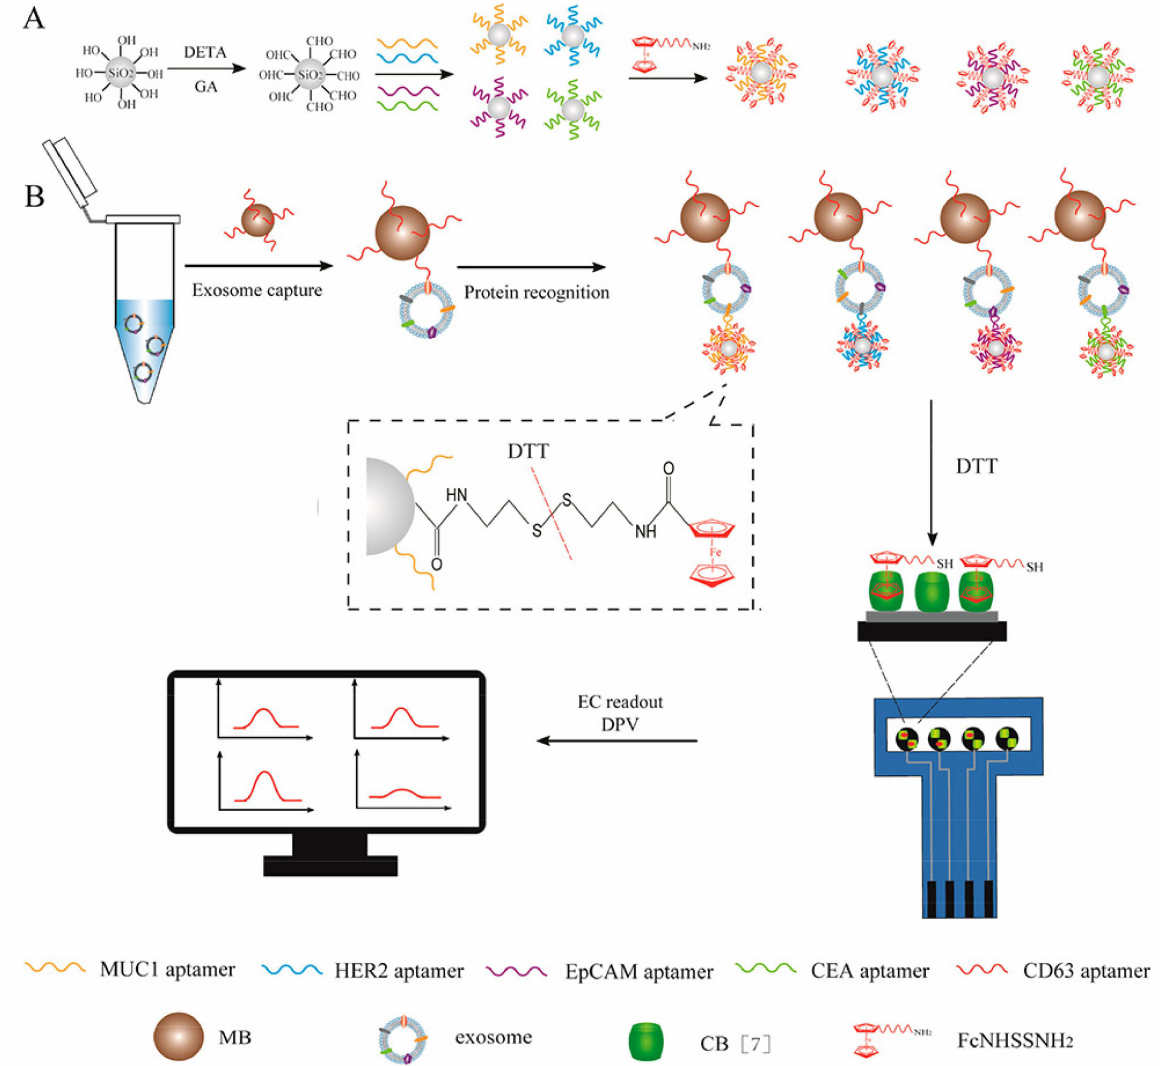
Figure 13. Schematic illustration of the magneto-mediated Electrochemical Sensor. ( A ) The prepa- ration of “signaling probe” structures containing silica nanomaterials (SiO 2 NPs) modified with MUC1, HER2, EpCAM, or CEA aptamers and ferrocene.; ( B ) Schematic illustration of the exosome analysis protocol performed between CD63 protein-specific aptamer-modified magnetic beads (MB) and the signaling probe. Reprinted with permission from Ref. [105]. Copyright 2020, American Chemical